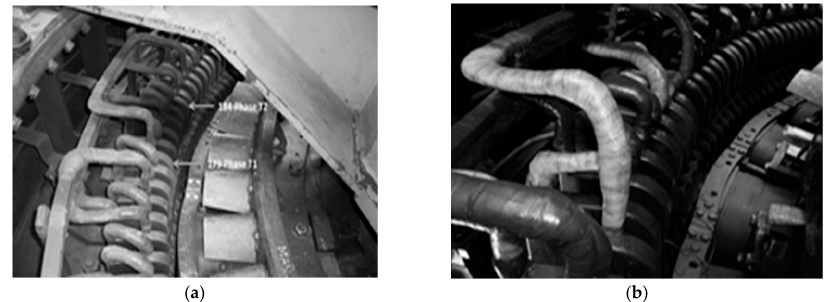
Figure 4. Fault indication and mitigation in the stator winding of generating unit (GU) #1: ( a ) fault indication; ( b ) fault mitigation.